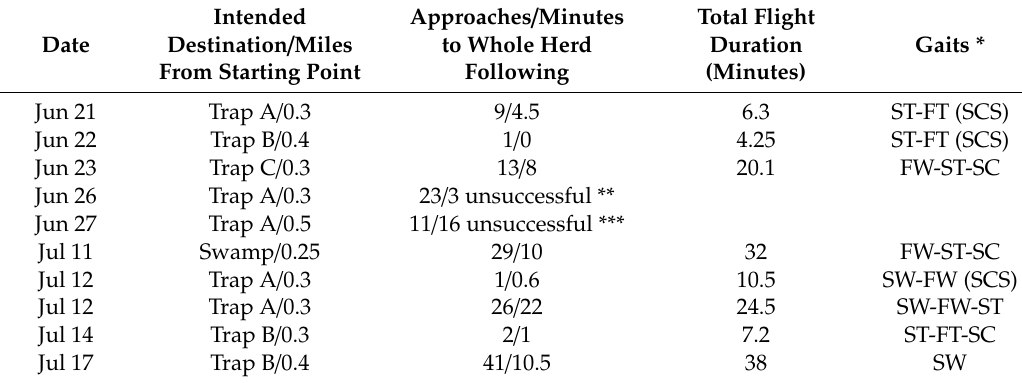
Table 1. Summary of drone